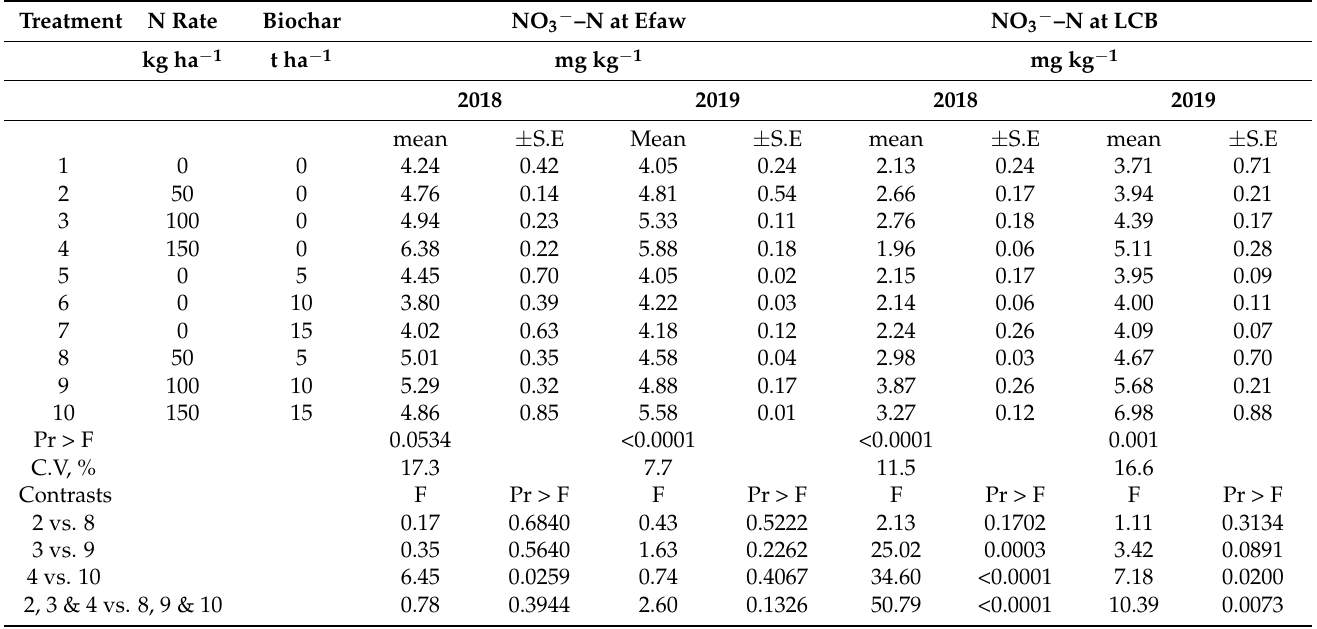
Table 2. Mean nitrate N for treatments plus the associated contrasts between N fertilizer and biochar- N combinations at Efaw and Lake Carl Blackwell, Stillwater, Oklahoma. 2018 and